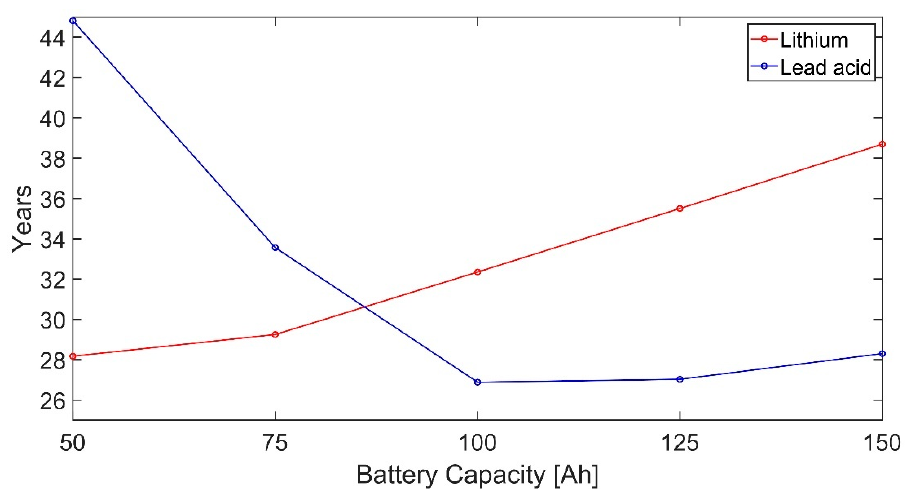
Figure 7. Behavior of the payback period of the lithium and lead-acid batteries according to different capacities.